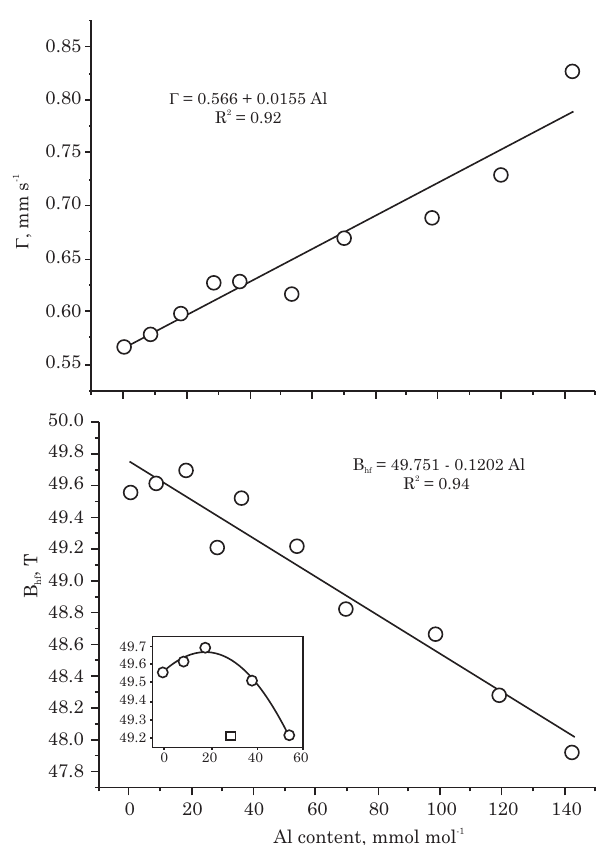
maghemites.Figure 4. Linewidth ( ΓΓΓΓΓ ) of the Mössbauer spectra (a), and hyperfine magnetic interaction (B hf ) (b) for synthetic aluminum substituted maghemite. ( ooooo ) Outlier.